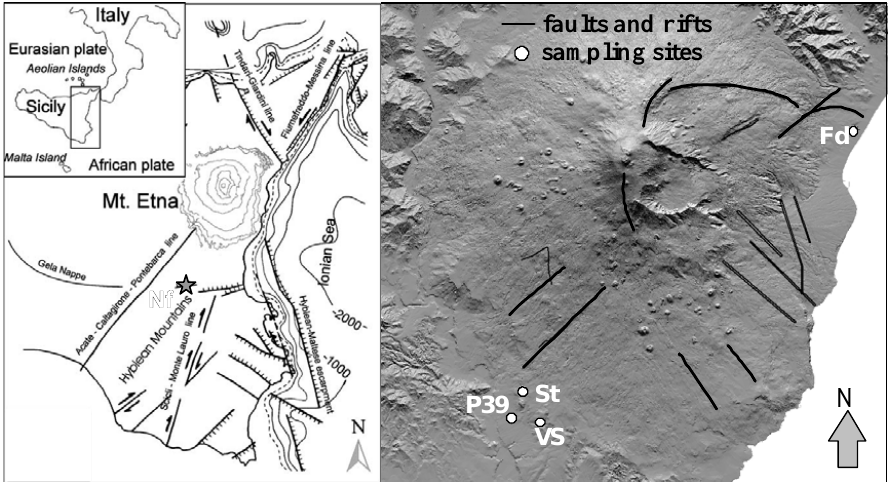
Fig. 1. Sketch map of Eastern Sicily and detail of Mt. Etna, with positioning of main tectonic lineaments and faults (modified from Patan`e et al., 2006). Sampled gas discharges are also displayed (see text for